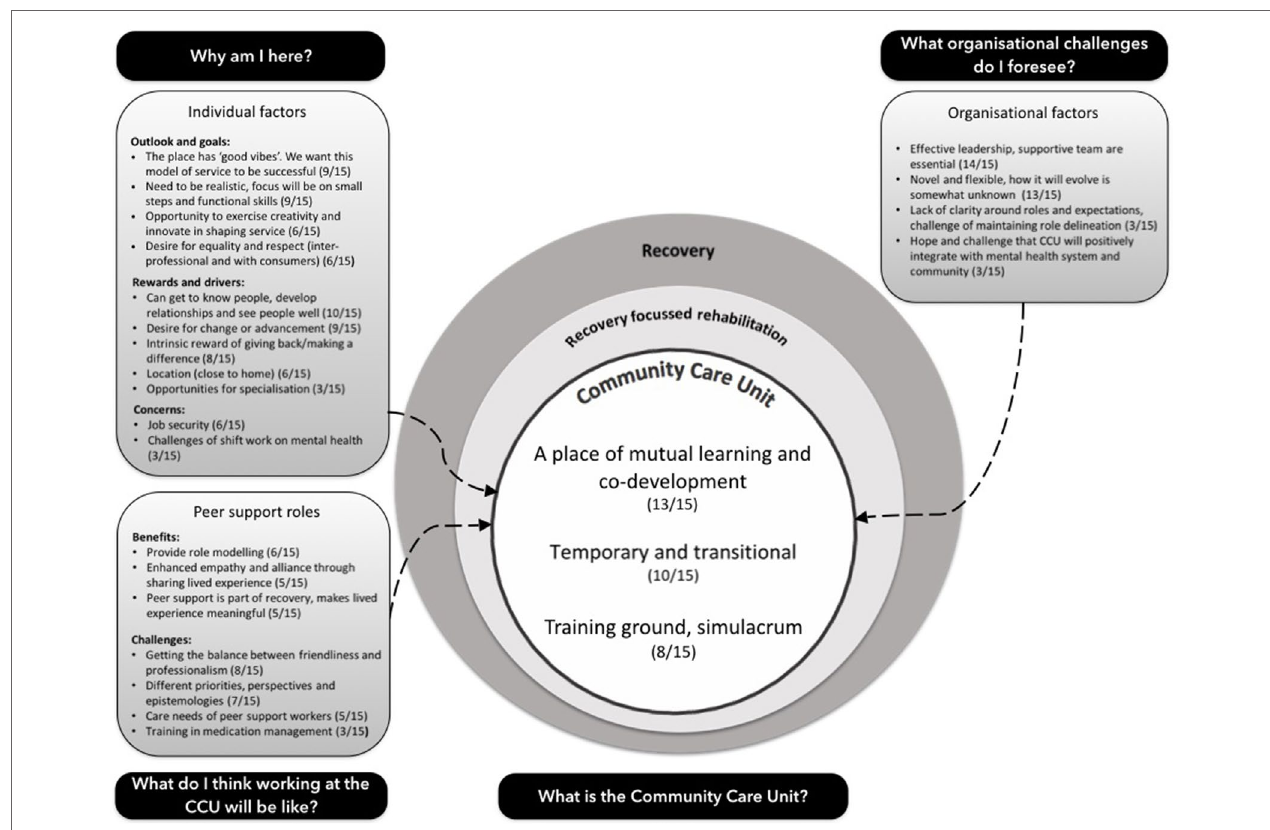
FIGURE 1 | Conceptual model arising from qualitative interviews of staff expectations.